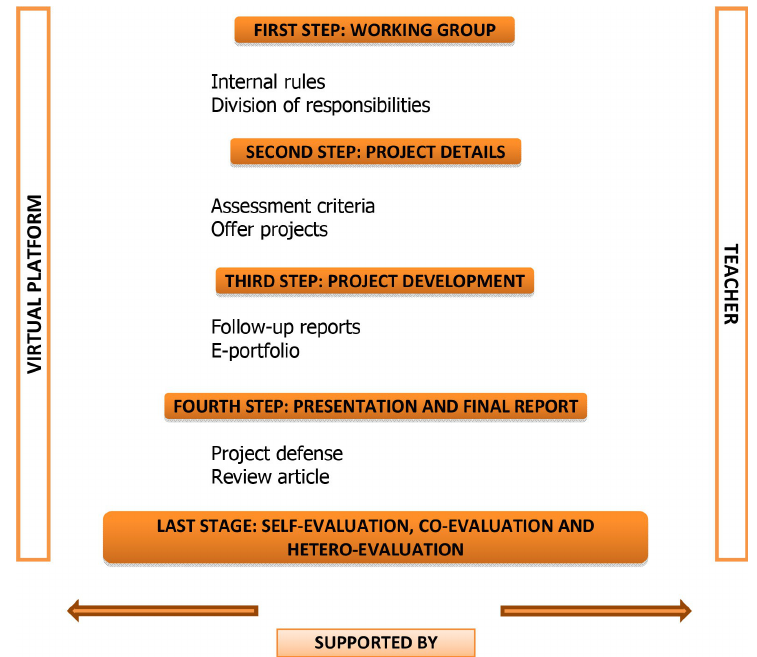
Figure 2. Proposed methodology